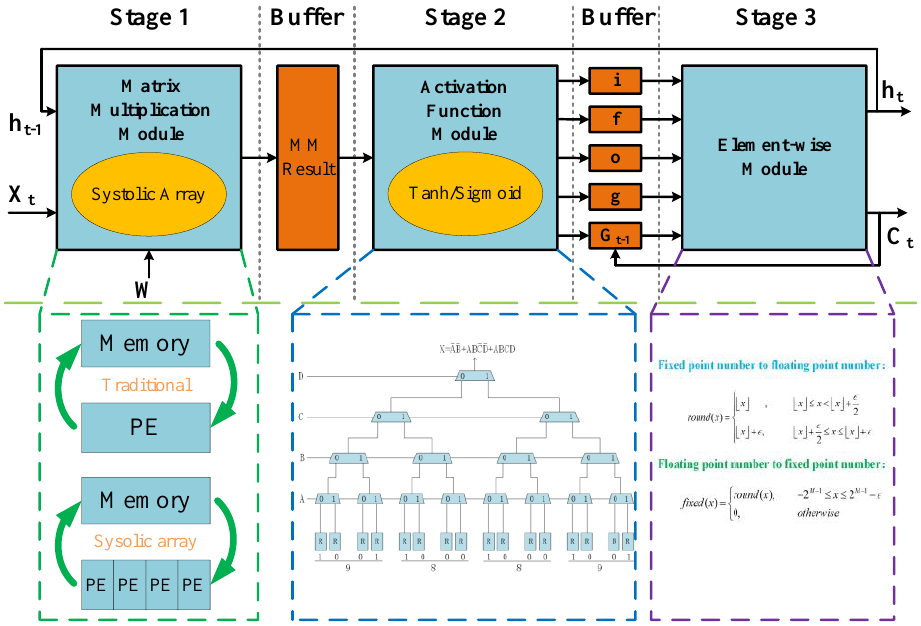
Figure 15. System structure of the LSTM accelerator.